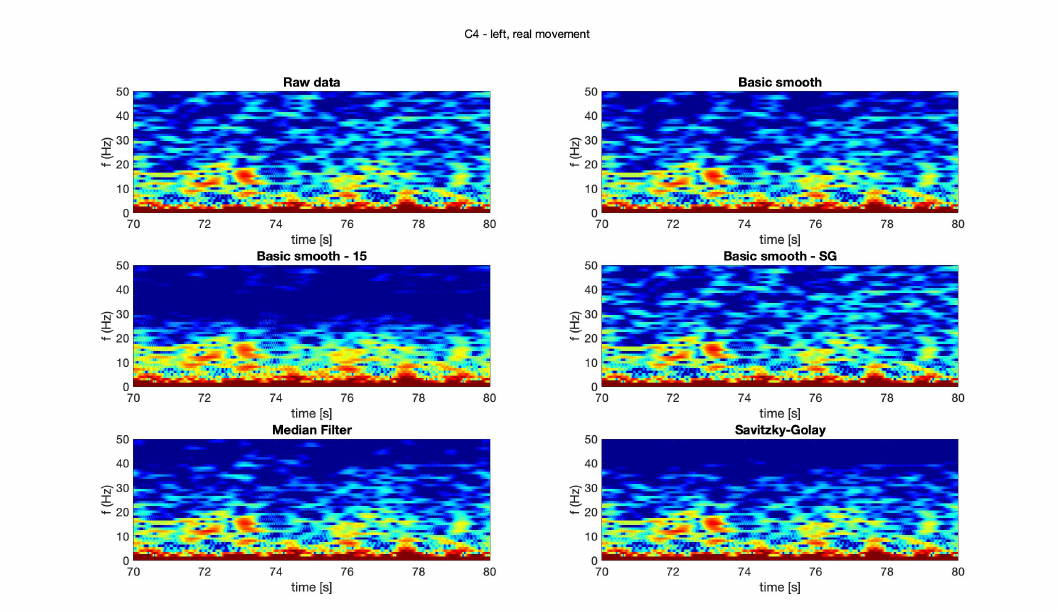
Figure 7. Spectrogram—C4, left hand, real movement.